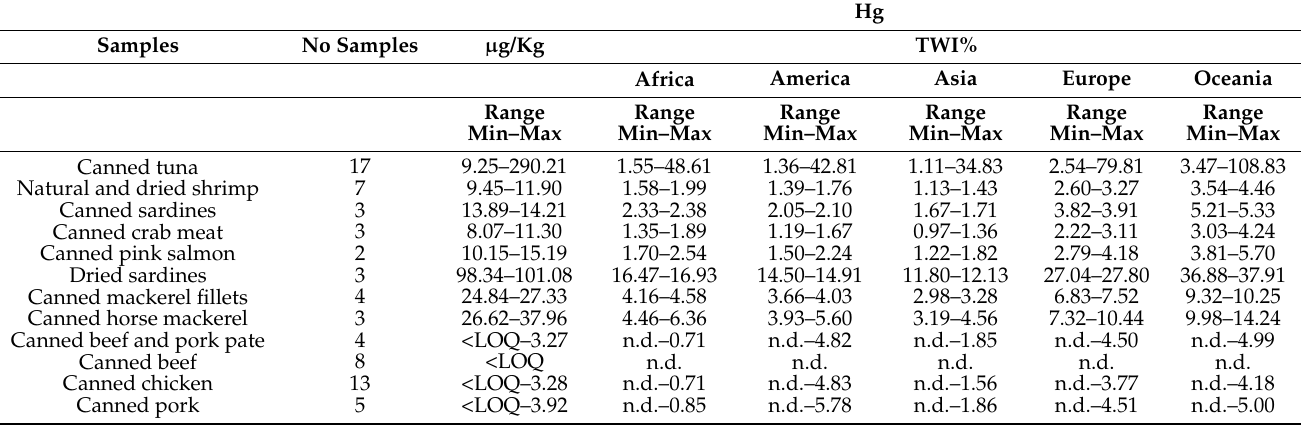
Table 5. Tolerable weekly intake (TWI) % values for Hg contents in relation to different dietary habits.